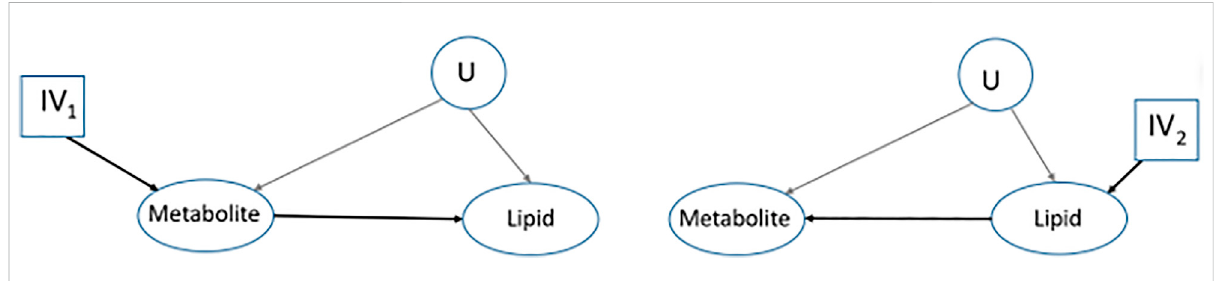
FIGURE 3 A transition from the classical MR framework. Interest is in fi nding the causal relationship between a metabolite and a lipid where we do not know which one is the response. Two of the possible causal diagrams are represented and each one will be assessed separately to select the most likely causal